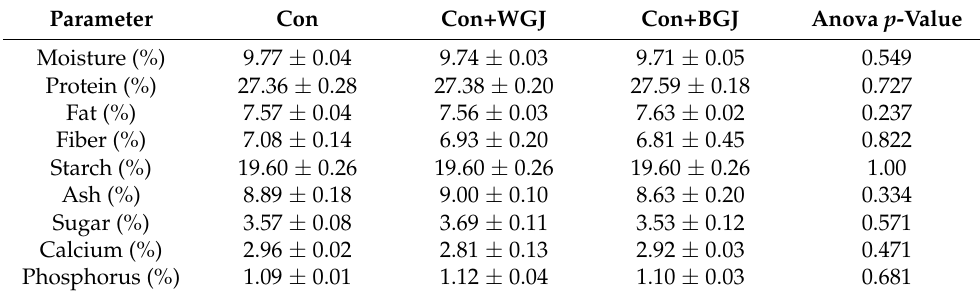
Table 2. Proximate biochemical composition of the experimental plant-based diets for common carp.